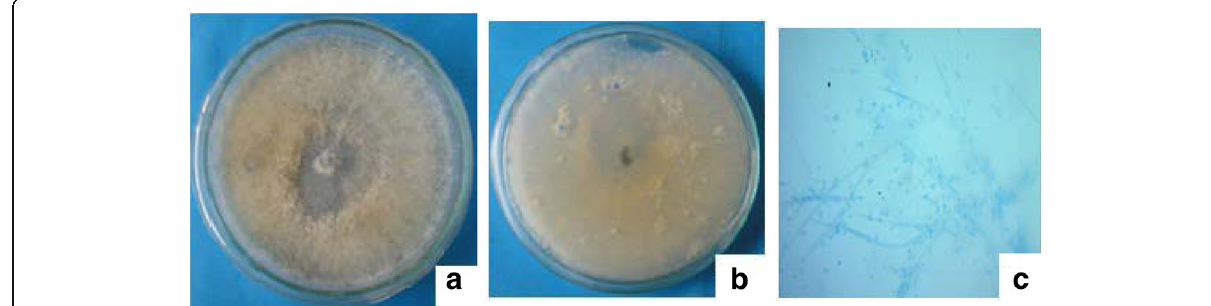
Fig. 2 Macroscopic front ( A ) macroscopic ( B ) and microscopic ( C ) view of Fusarium sp. The pictures ( A, B ) represent macroscopic view of Fusarium sp. from bark of C. decandra after 12 days of cultivation on PDA media and also represent microscopic view (40X) ( C